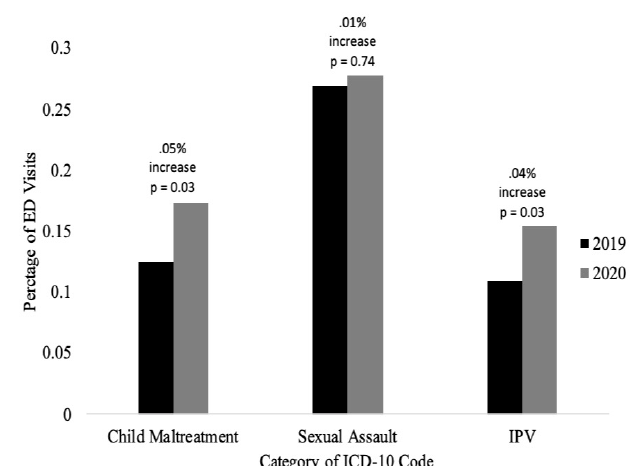
Figure 5. Percentage of emergency department visits with ICD- 10* codes related to child maltreatment, sexual assault, and intimate partner